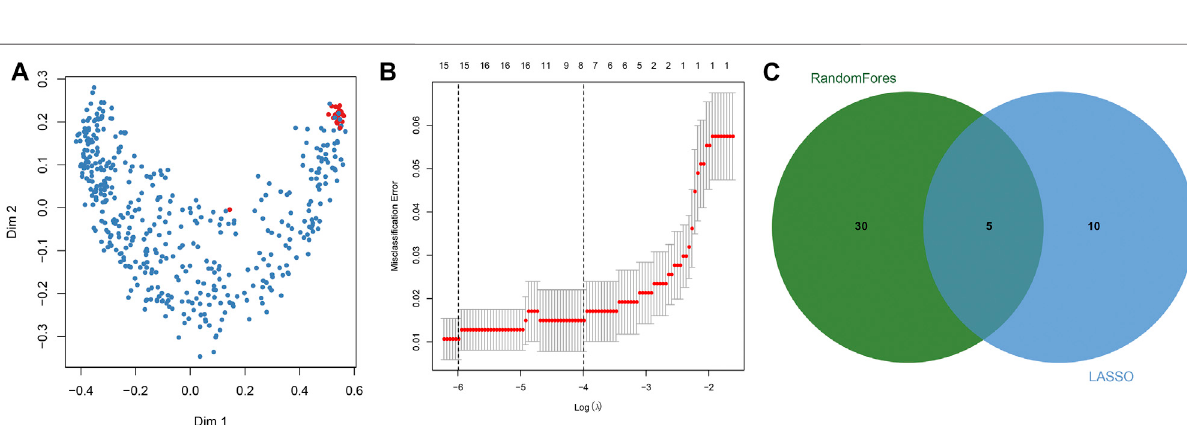
Frontiers in Genetics |